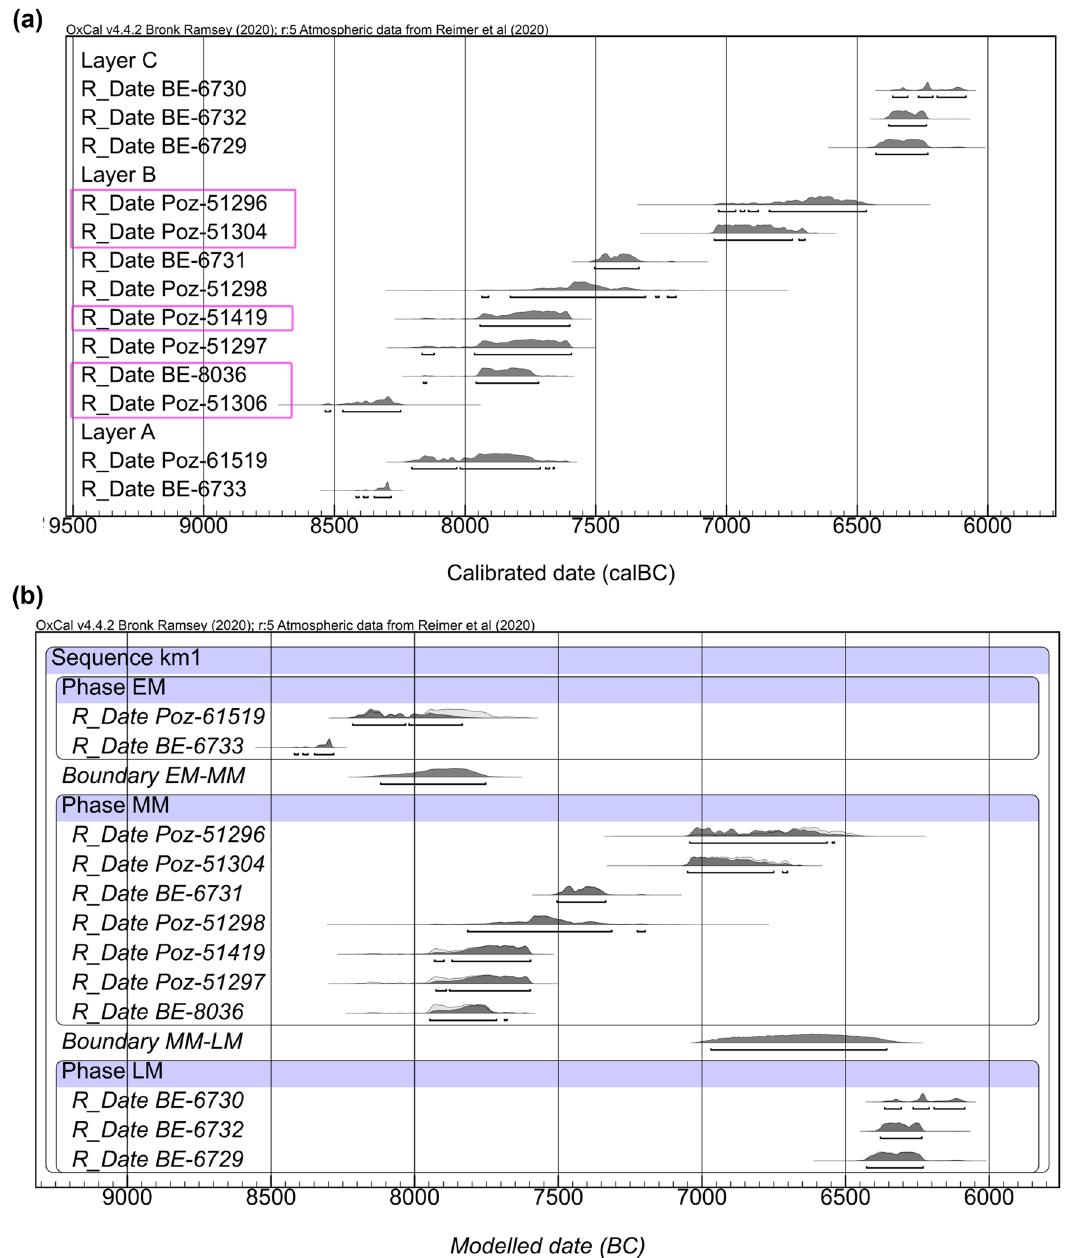
Figure 7: ( a ) Calibration of AMS dates for the Kamyana Mohyla 1 site ( in the order of appearance ) . Dates on animal bones are in purple rectangles. Other dates are on charcoal. ( b ) Modelled calibration of AMS dates for the Kamyana Mohyla 1 site. EM – Early Mesolithic ( layer A ) , MM – Middle Mesolithic ( layer B ) , LM – Late Mesolithic ( layer C )